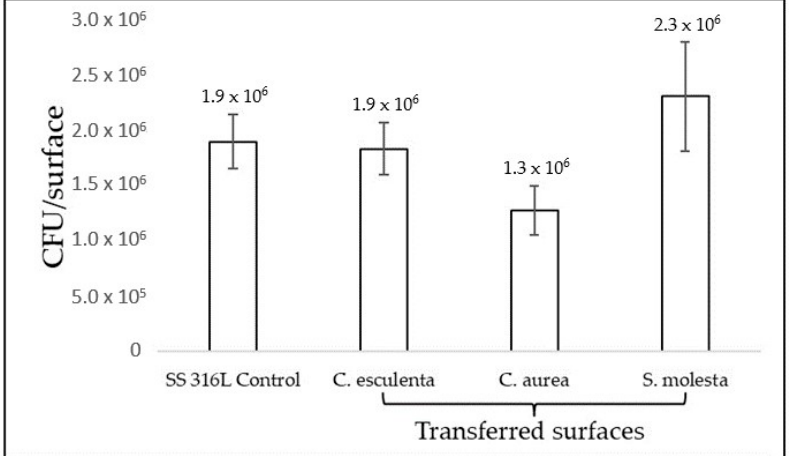
Figure 6. S. mutans adhesion to control (SS 316L) and transferred (experimental) surfaces.